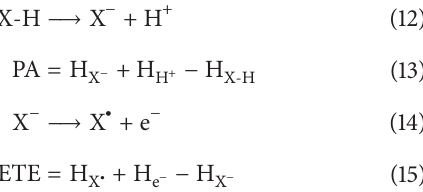
(i) The Direct Hydrogen Atom Transfer (HAT). The